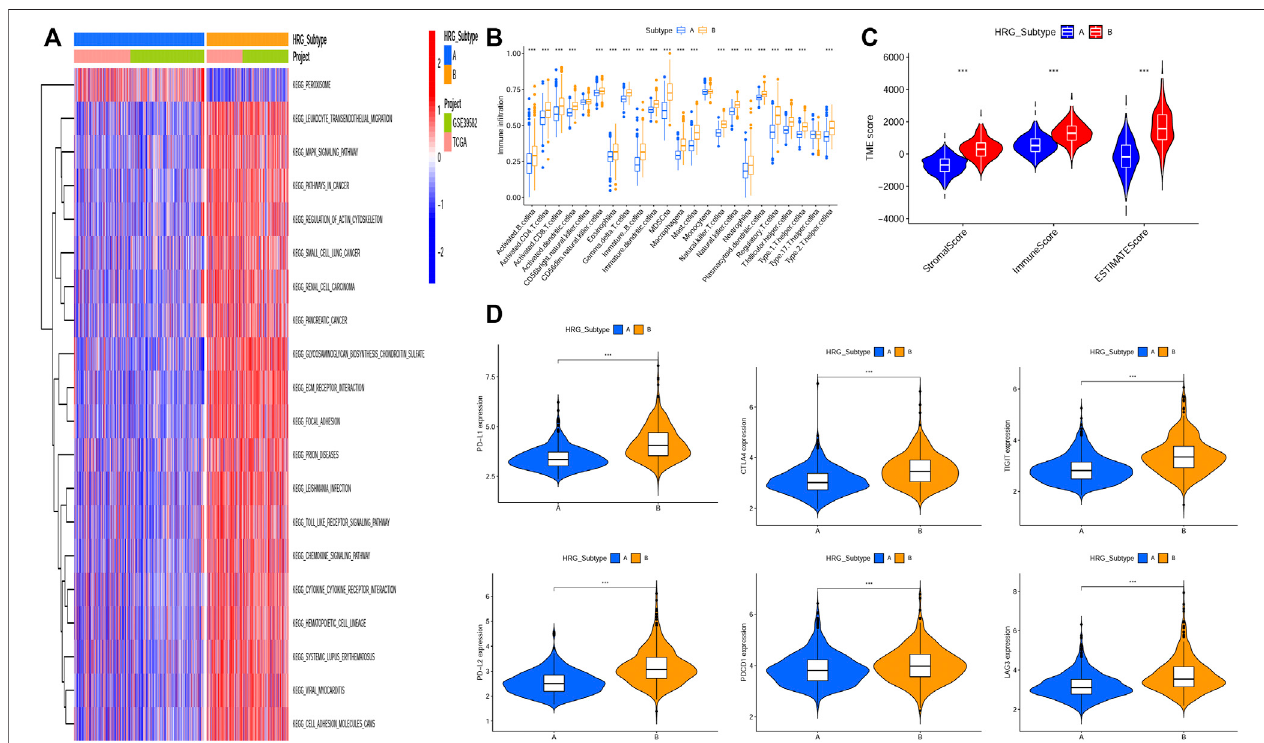
FIGURE 2 | Correlations of tumor immune cell microenvironments and two HRG-subtypes. (A) GSVA of biological pathways between two distinct subtypes, in which red and blue represent activated pathways and blue represents inhibited pathways, respectively. (B) Relative abundance of 23in fi ltratingimmunecell types in the twoHRG-subtypes. (C) CorrelationsbetweenthetwoCRCsubtypesandTMEscore. (D – I) ExpressionlevelsofPD-L1, PD-L2,PDCD1,LAG3, TIGIT,andCTLA4intwo distinct HRG-subtypes. (* p < 0.05; ** p < 0.01; *** p <